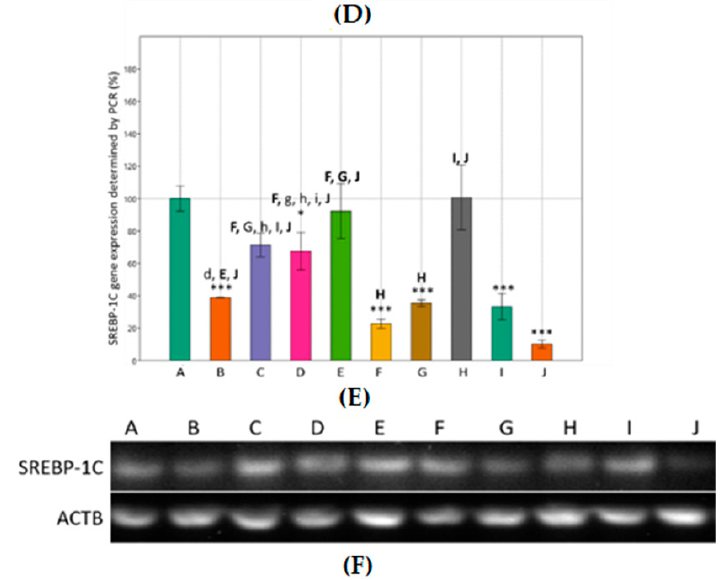
Figure 3. Effects of metformin and simvastatin on expression of adipogenic genes in 3T3-L1 cells, determined by RT-PCR. A = differentiated cells, B = cells treated with metformin 200 µM, C = cells treated with metformin 2 mM, D = C = cells treated with metformin 4 mM, E = cells treated with simvastatin 100 nM, F = cells treated with simvastatin 1 µM, G = cells treated with simvastatin 2 µM, H = cells treated with the combination of metformin 200 µM and simvastatin 100 nM, I = cells treated with the combination of metformin 2 mM and simvastatin 1 µM, J = cells treated with the combina- tion of metformin 4 mM and simvastatin 2 µM, PPAR γ = peroxisome proliferator-activated receptor γ , C/EBP α = CCAAT/enhancer binding protein α , SREBP-1C = sterol regulatory element-binding